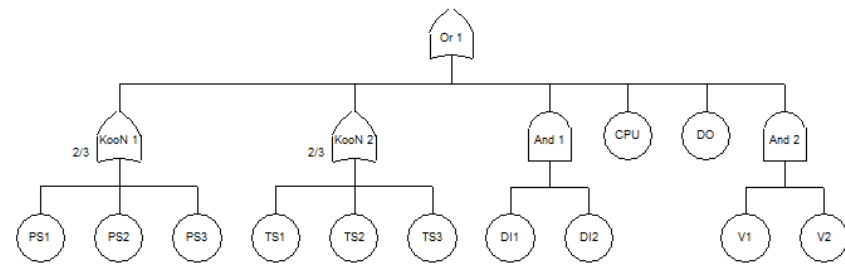
Figure 20. The structure I of E/E/PE safety-related system.